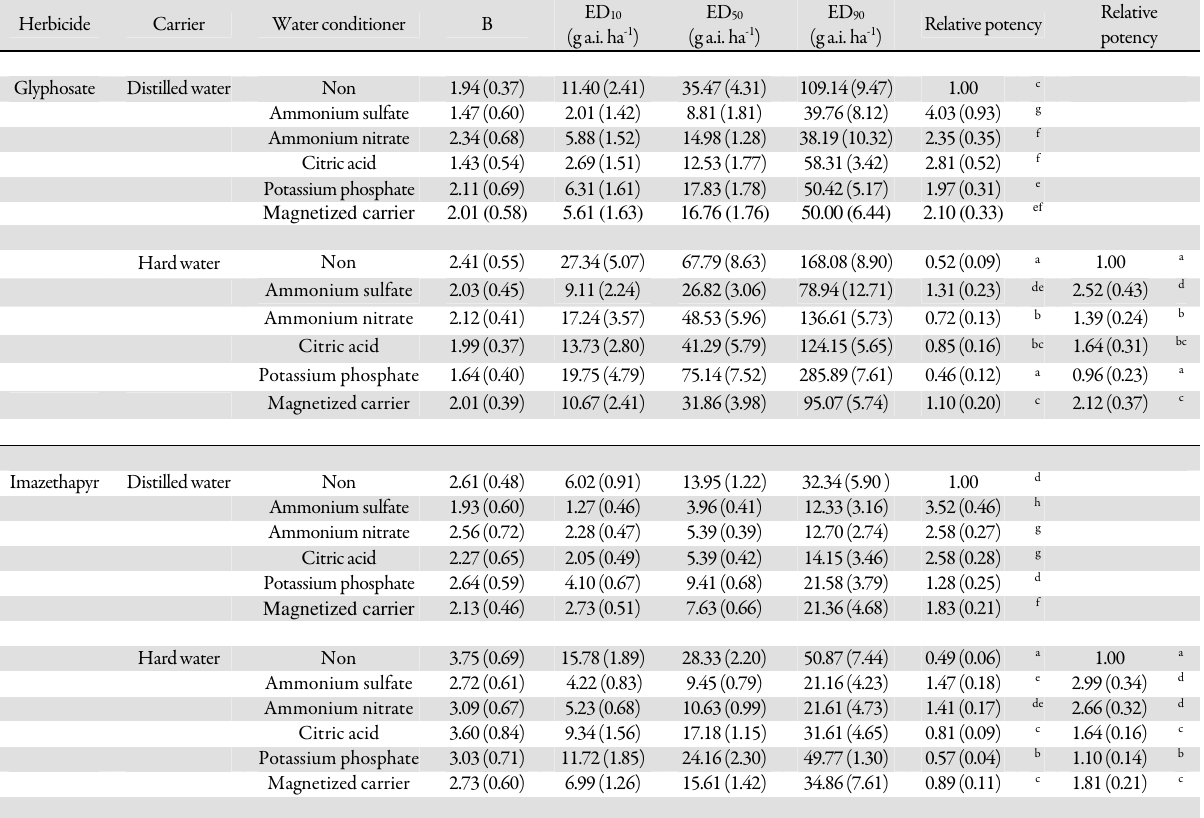
and 95% control, respectively. The standard errors are in parentheses. In each column, relative potencies followed by same letter are not significantly different at the 0.05 probability level